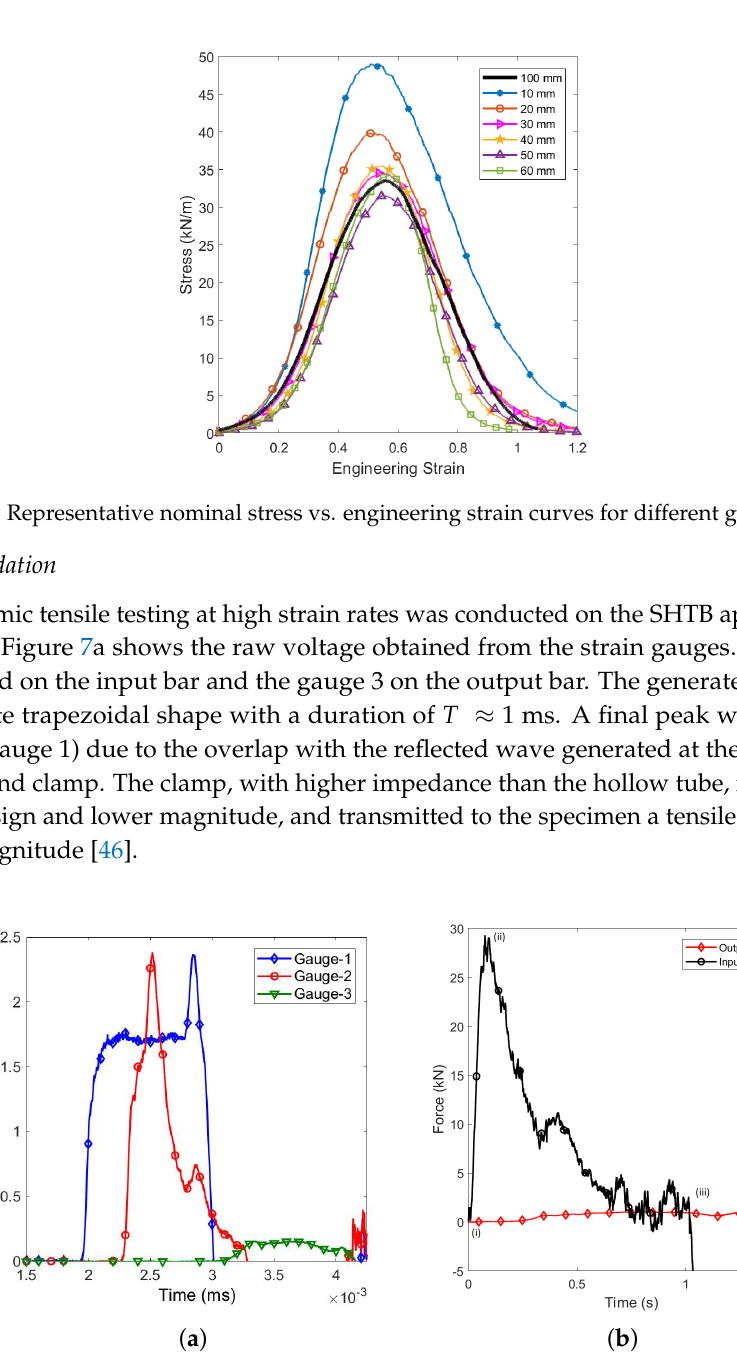
Figure 7. ( a ) Voltage vs. time for each strain gauge. The gauges 1 and 2 were installed in the input bar and the gauge 3 was installed in the output bar. ( b ) Forces vs. time monitored at input and output bar